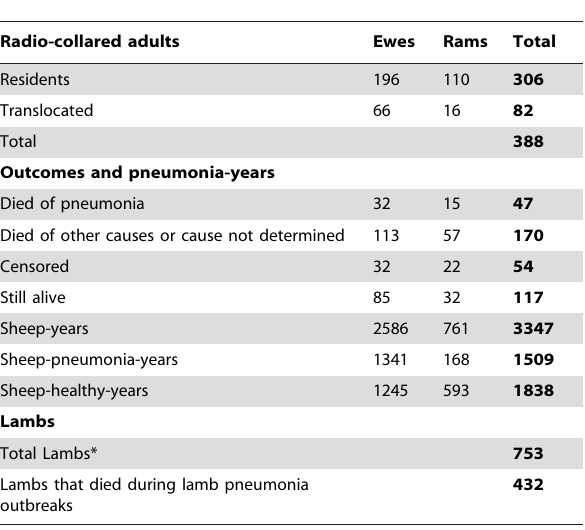
Table 2. Number of animals included in the